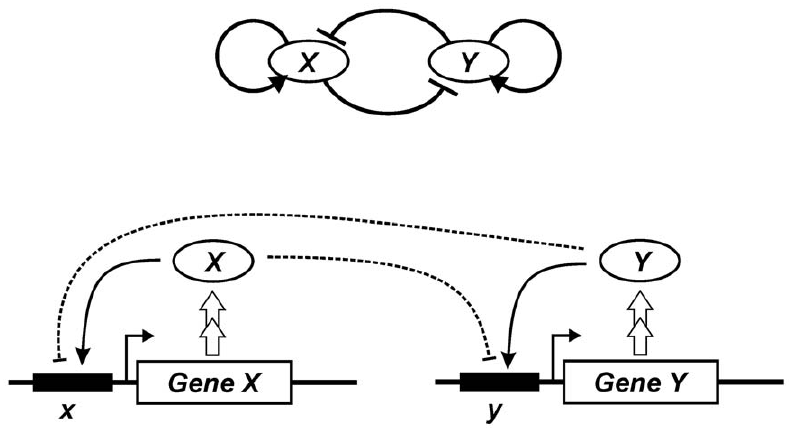
Figure 1. The generic architecture of the self-activation and mutual repression two-gene circuit. Top: coarse-grained circuit scheme for the circuit of two genes X and Y as a dynamical system ; bottom: molecular mechanism model amenable for a more detailed chemical reaction kinetics formalism, indicating the variables for the model due to the distinction between genes/promoters ( x and y ) and the transcription factor proteins ( X , Y ). Note that the modality for how the two inputs at each promoter, self-activation and cross inhibition is not specified by the scheme.